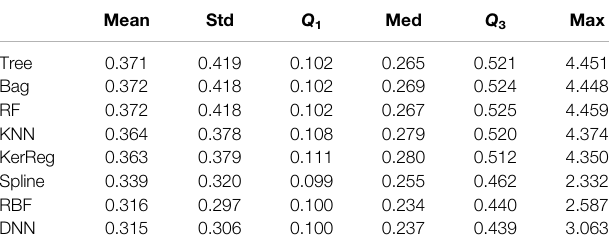
TABLE 5 | Performances of all the methods trained on TRAIN_M13 and tested on TEST_M13_L. We consider the absolute error | e i | and report the mean error, standard deviation, fi rst quartile, median error, third quartile, and maximal error. Mean Std Q 1